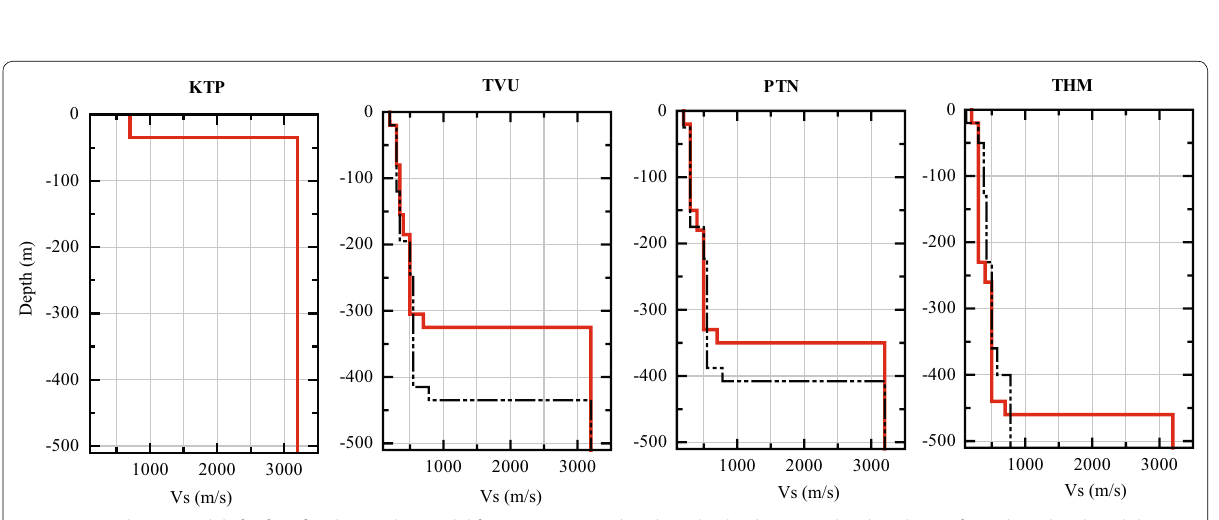
Fig. 8 1-D velocity models for four fixed sites. The model for KTP was considered as a bedrock site overlain by a layer of weathered rock and those for TVU, PTN, and THM are adjusted 1-D velocity models. Site THM has the thickest sediment . The black dashed lines indicate the initial velocity